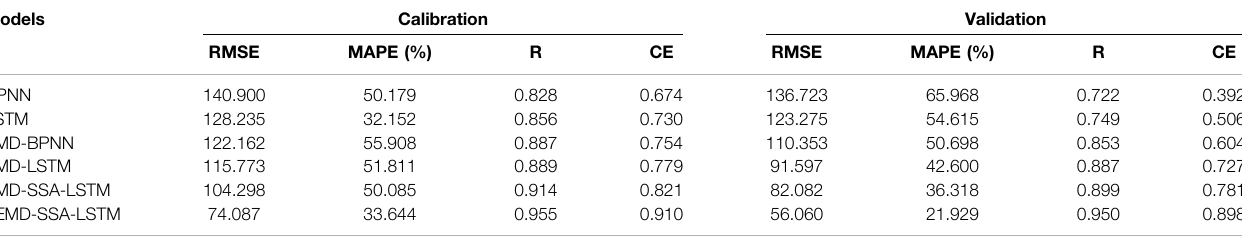
TABLE 3 | Comparison of evaluation indexes of different models for the Guangzhao Reservoir. Models